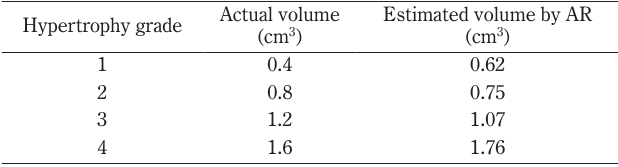
Table 2 Estimated and actual nasopharyngeal airway volumes by grade of adenoidal